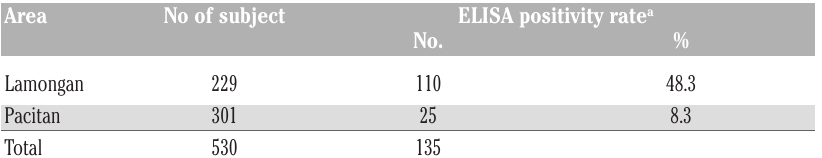
Table 1. ELISA positivity rate among healthy school children by geographic area.